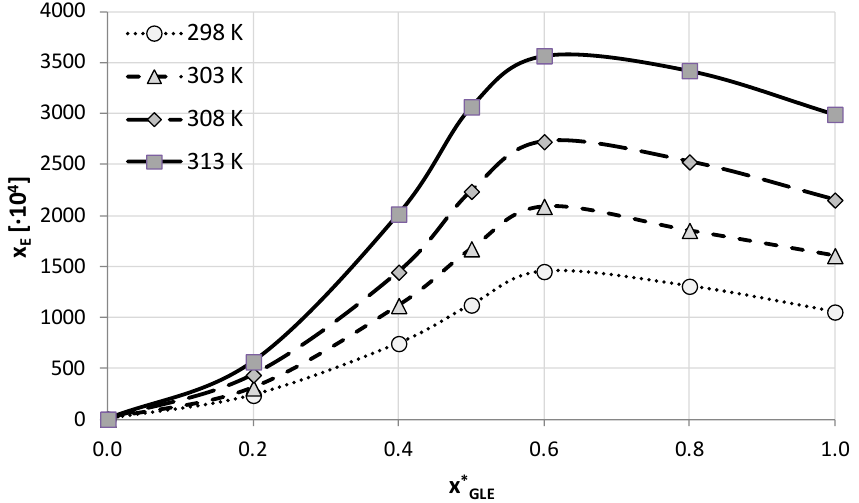
Figure 1. Mole fraction solubility of edaravone in mixtures of water and GLE (ChCl:GL = 1:2 molar ratio). On the abscissa, x *GLE represents the mole fractions of the GLE in solute-free solutions. Detailed results are available in Table S1 in Supplementary Materials.